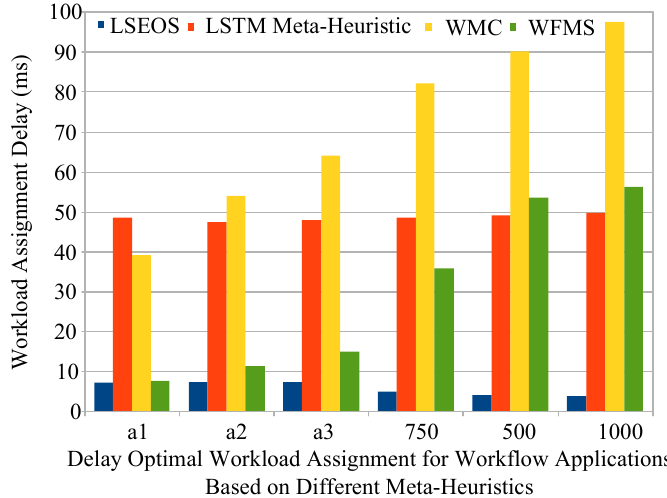
Figure 8. Lightweight workflow task assignment delay